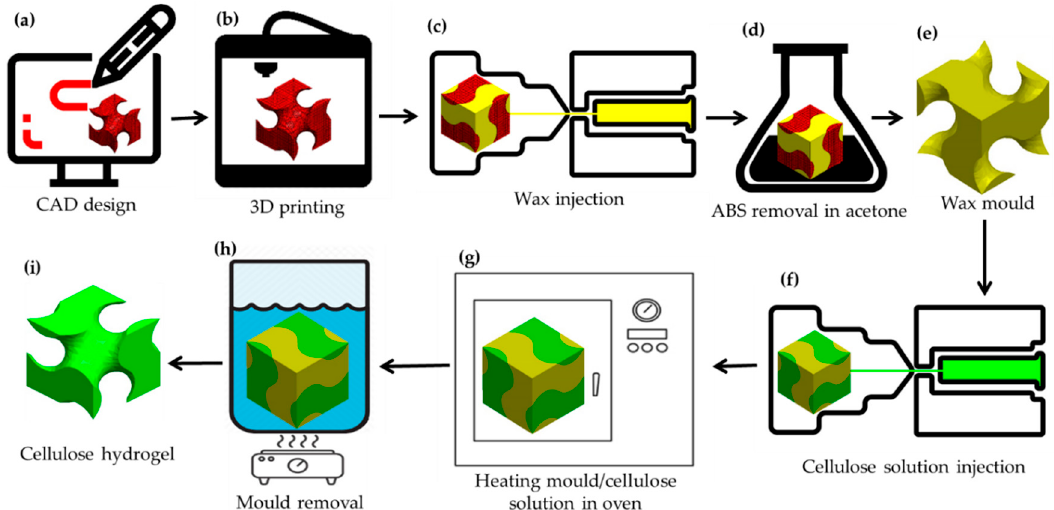
Figure 1. Steps in the fabrication of structured porous cellulose hydrogel: ( a ) CAD design of network gyroid with 1-mm channel size, ( b ) gyroid mould three-dimensional (3D) printed out of acrylonitrile butadiene styrene (ABS) using Up-box mini 2 3D printer, ( c ) wax injected into the 3D printed ABS, ( d ) ABS and wax mould in acetone solvent, ( e ) resulting wax mould after removal of ABS, ( f ) cellulose solution injected into the wax mould, ( g ) heating moulds to gel cellulose solution in an oven, ( h ) mould removal in 90 °C water and ( i ) final cellulose hydrogel.